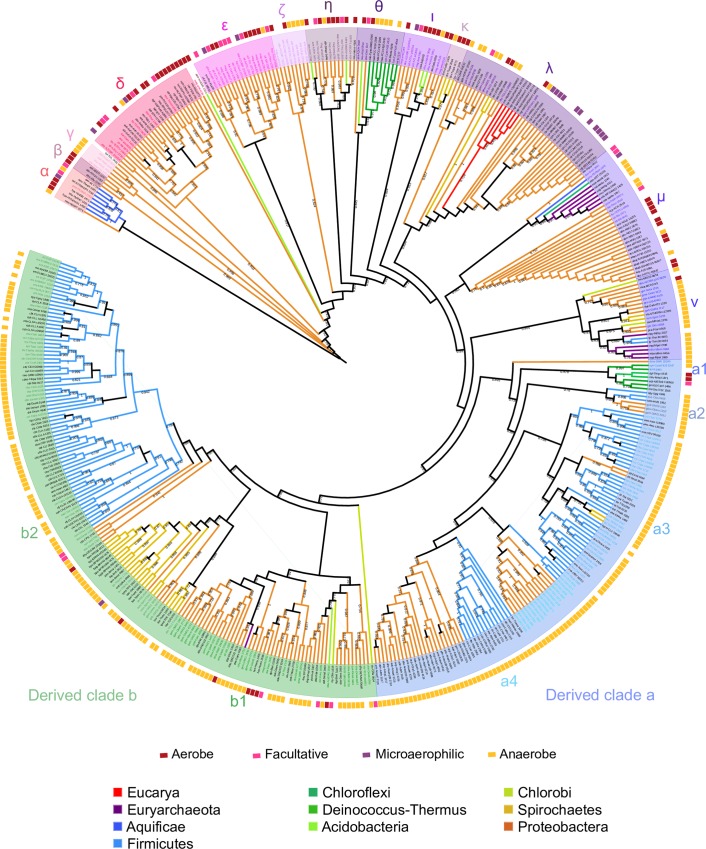
Maximum-likelihood tree of single-domain hemerythrin sequences.Internal nodes with approximate likelihood-ratio test lower than 0.6 were collapsed. Names of the sequences appear at the tips of the branches. Sub-clusters are named by Greek letters on the base of the tree and by letters and numbers in the direved clusters. Node names appear in color when there is at least another copy of single-domain O2-binding Hr in a separate cluster of the tree. Oxygen requirement of the species source, according to the Genomes OnLine Database [21], is indicated by color bars at the tips of the nodes.